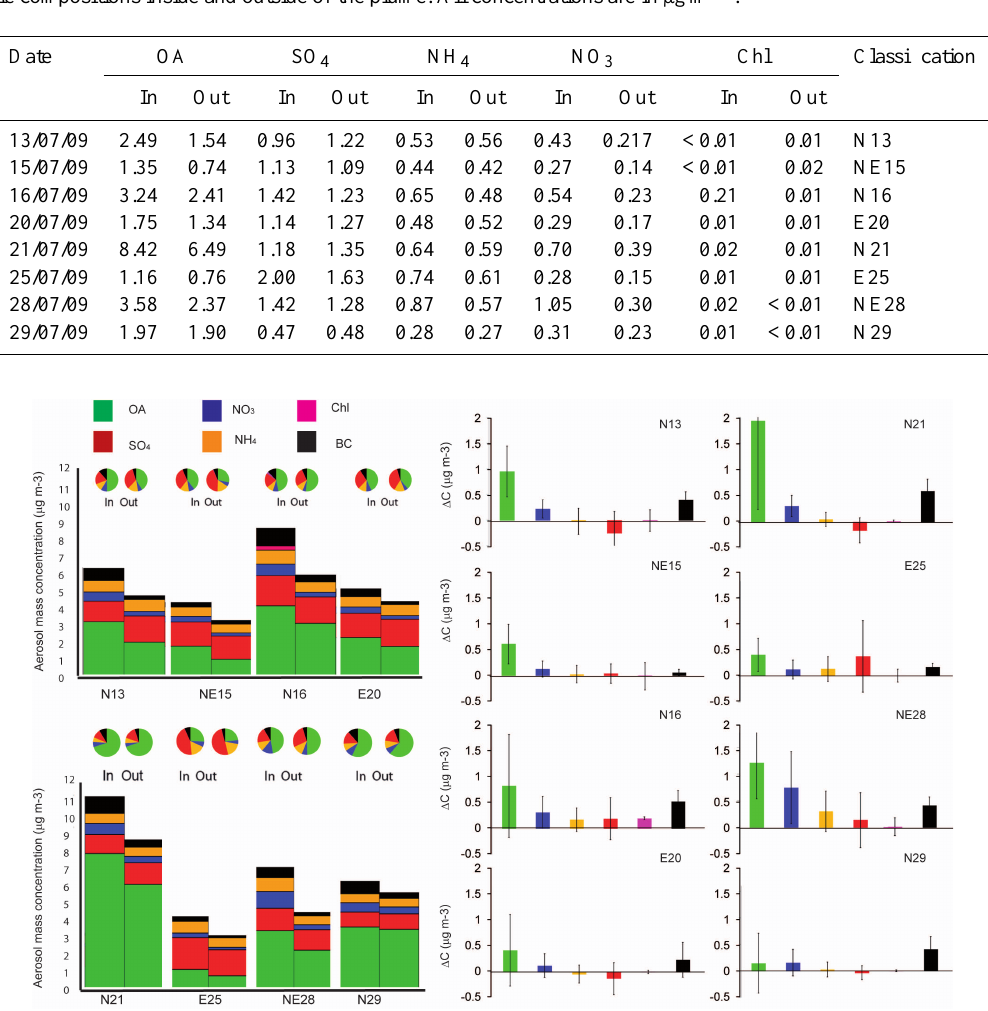
Fig. 3. The left-hand side of the figure shows the aerosol composition measured inside and outside of the plume during each research flight. On the right-hand side the average difference in composition ( 1 C) between the inside and the outside of the urban plume for each flight is shown. Error bars are the ± 1 σ standard